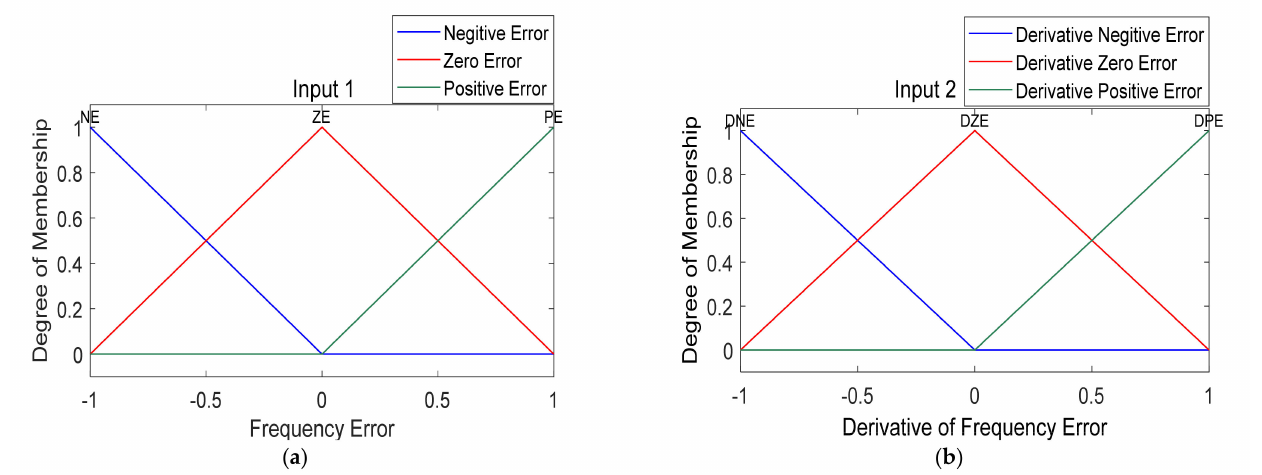
Figure 9. ( a ) Membership function, Input variable 1. ( b ) Membership function, Input variable 2.